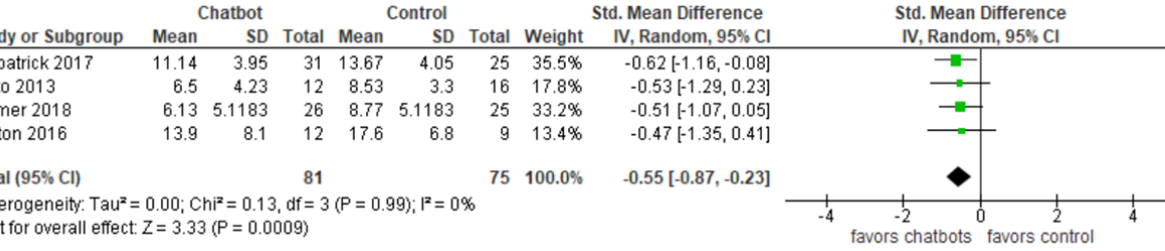
Figure 4. Forest plot of the 4 studies assessing the effect of using chatbots on the severity of depression.